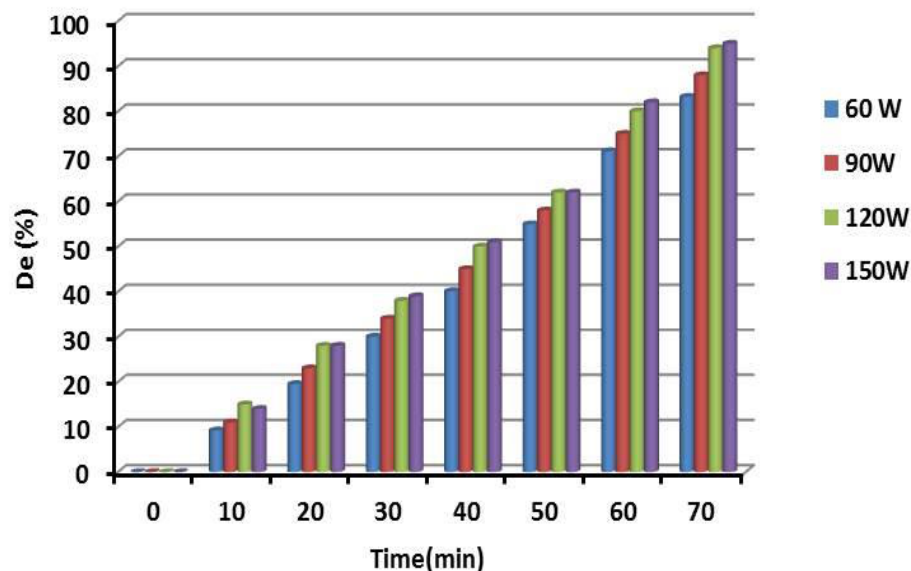
Fig. 12. Ultrasound power effect on the degrading RB 19 by diatomite coated 6 % Dy-doped Y